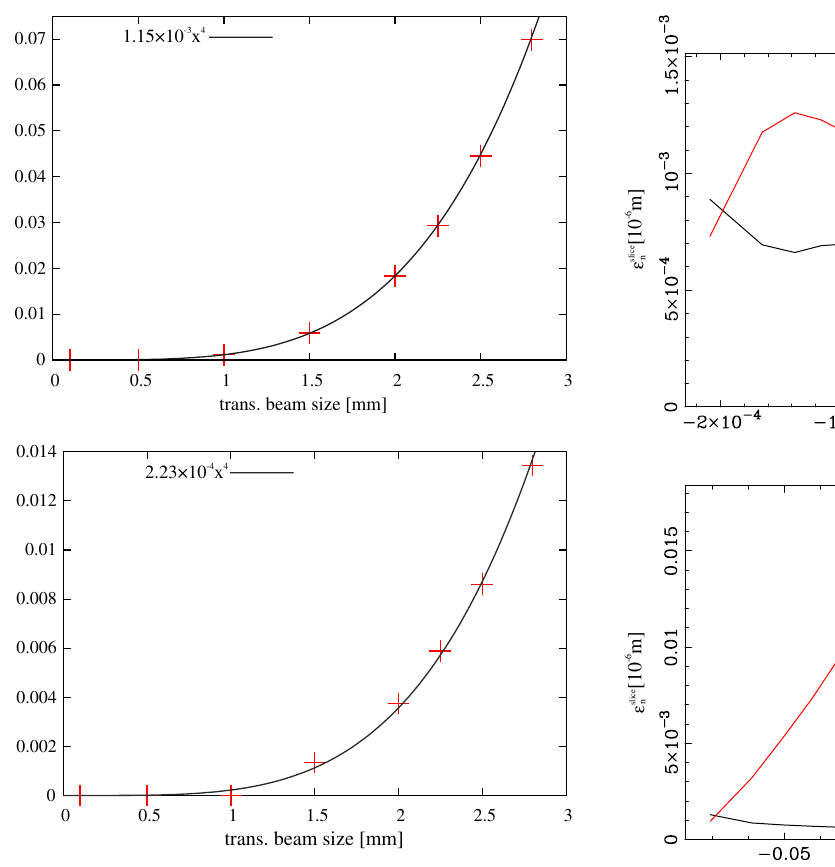
FIG. 4 (color online). Normalized emittance in a direction perpendicular to the streak vs beam size (top) and nonlinear normalized emittance in the streaking direction vs beam size for the compensated structure C at a beam energy of 50 MeV and power of 4 fit. Beam parameters are according to Table II.